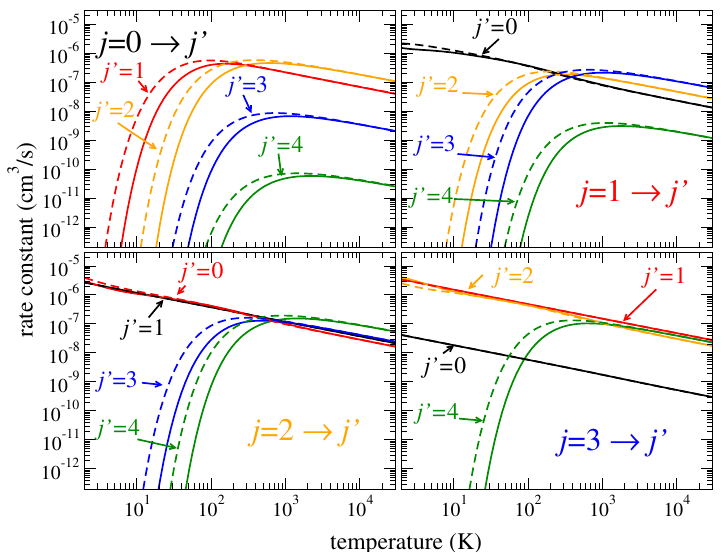
Figure 6. Same as Figure 5 for 3 HeH + (solid lines) and 3 HeD + (dashed lines). Rotational transition labels j → j (cid:48) are shown in each